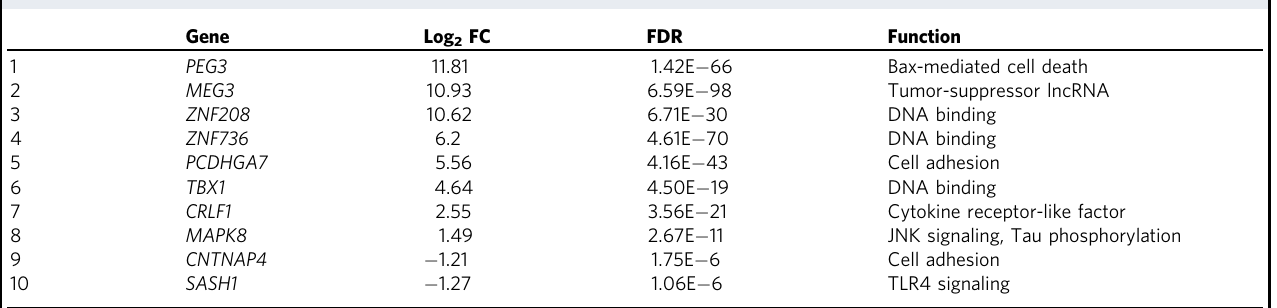
Table 1 Top ten differentially expressed genes common between the APP and NDC neurons and between the Iso and APP